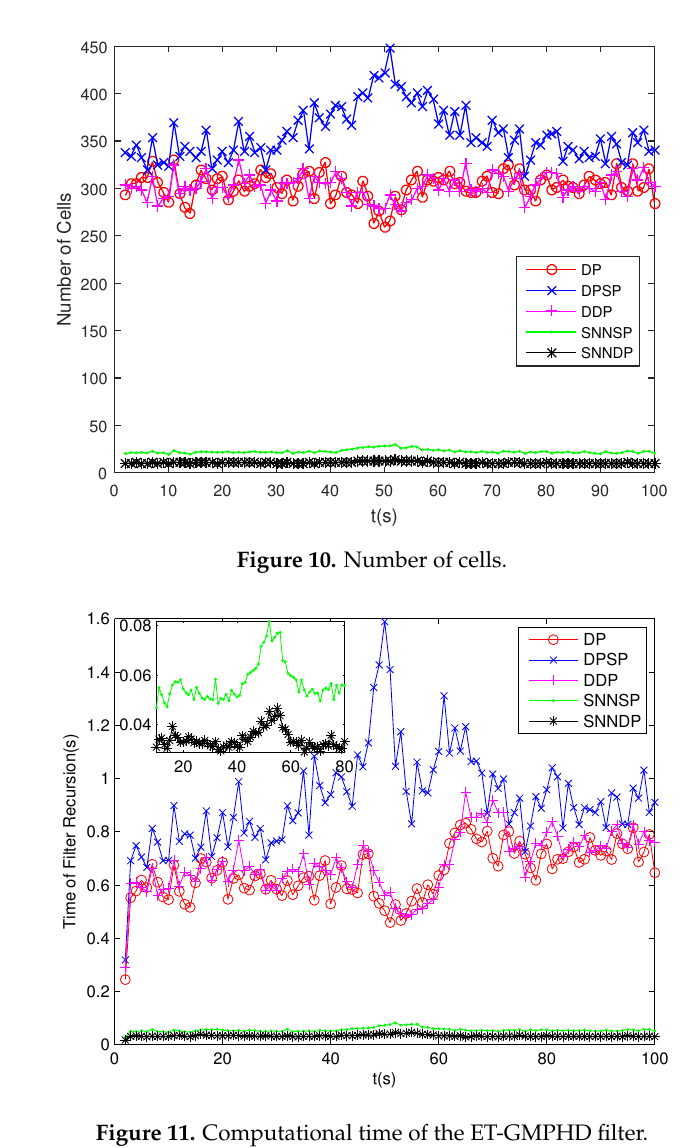
Figure 11. Computational time of the ET-GMPHD filter.